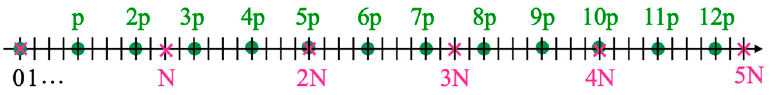
Figure 19. Multiples of N are enclosed by immediately succeeding multiples of p. Note 8.